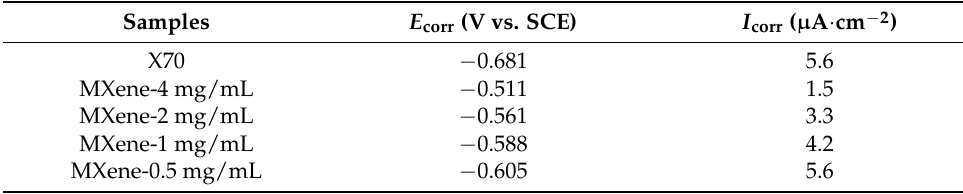
Figure 6. Tafel curves of the substrate and samples with different concentrations. Table 2. Electrochemical properties of the coatings derived from the Tafel curves.